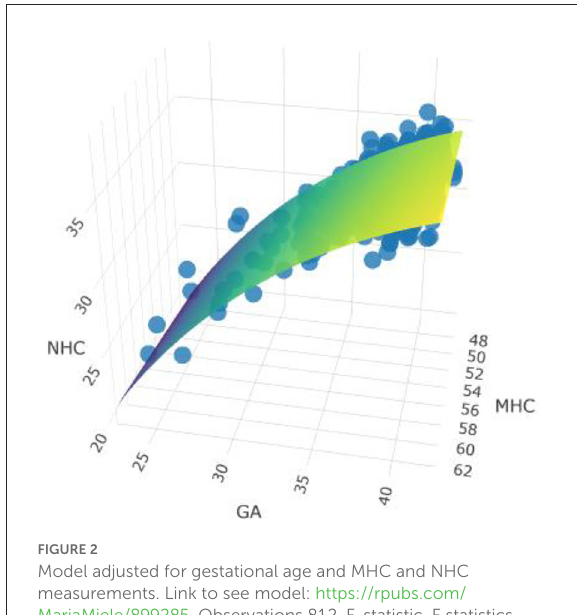
FIGURE2 Model adjusted for gestational age and MHC and NHC measurements. Link to see model: https://rpubs.com/ MariaMiele/899285. Observations 812, F-statistic, F statistics p -value < 0.001. Adjusted R 2 /R 2 ajusted: 0.145/0.143.